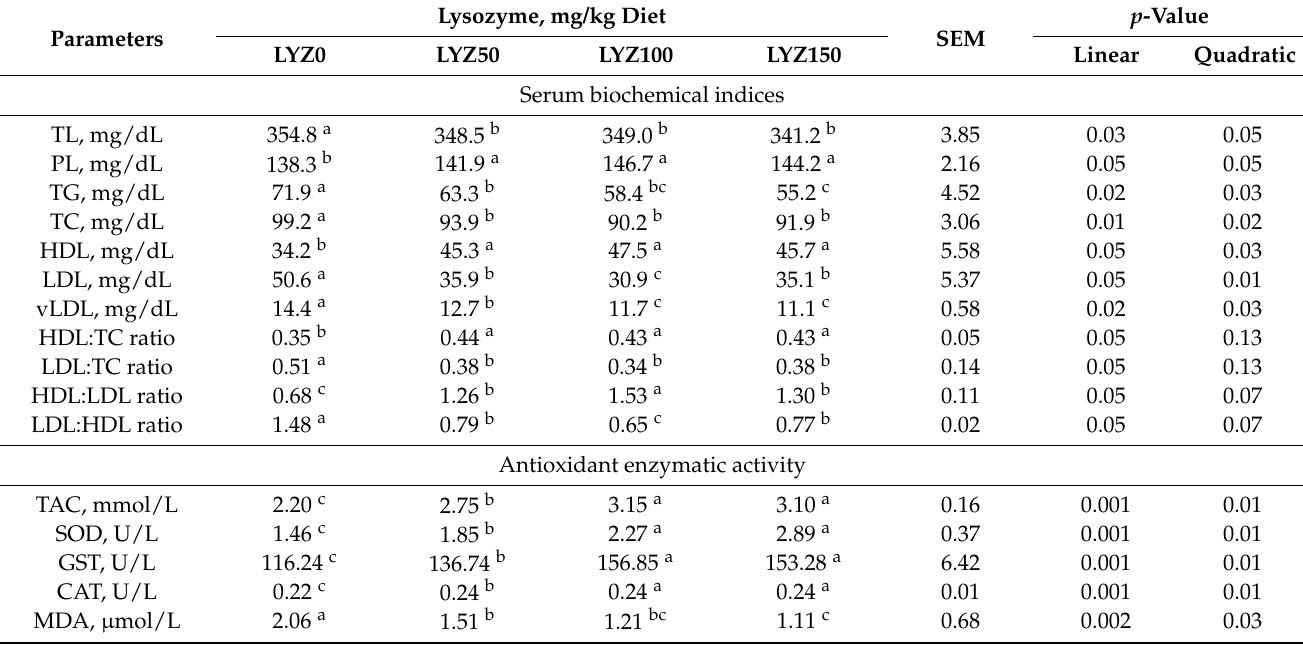
Table 6. Serum biochemical indices and antioxidant status of growing rabbits fed diets supplemented with different levels of